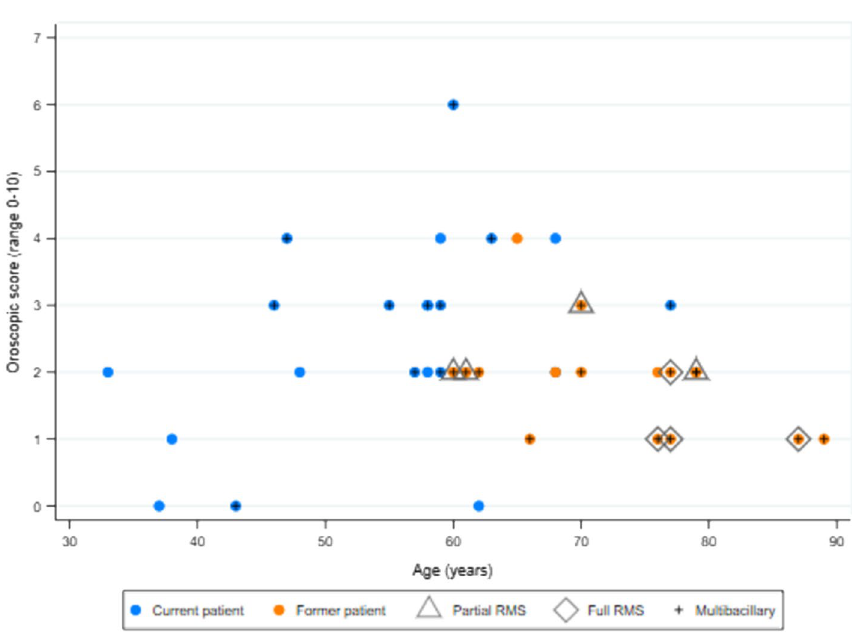
Figure 6. Correlation between oroscopic score and age in current and former Hansen’s disease patients (see Table 4 for correlation